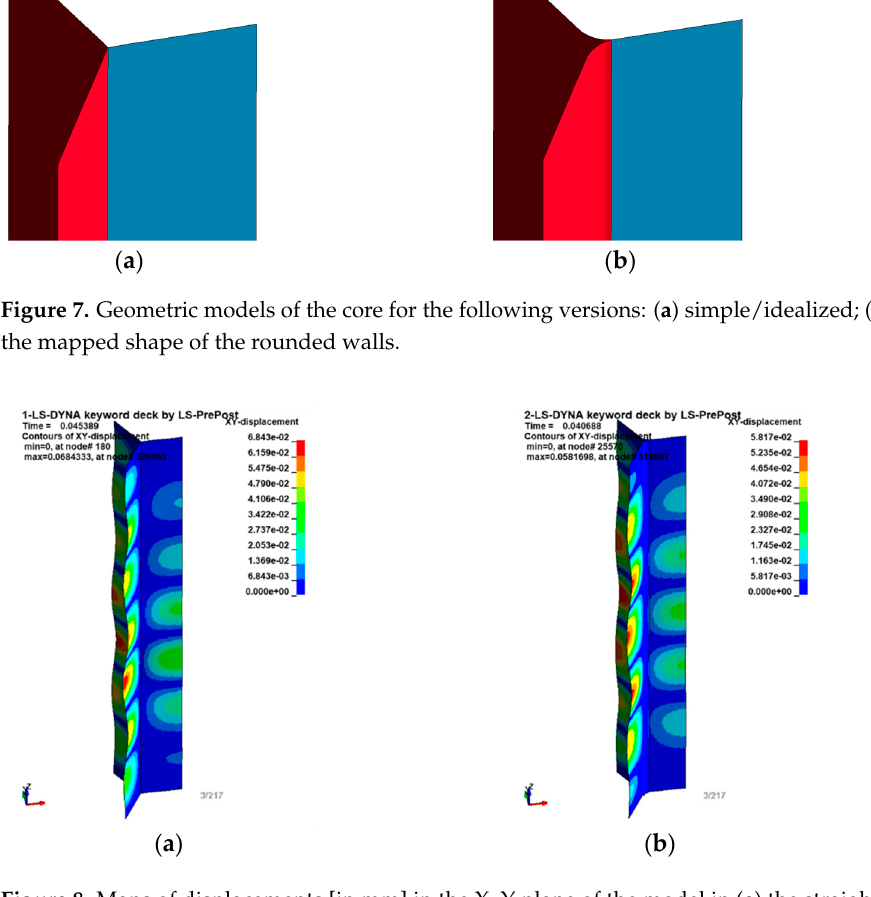
Figure 8. Maps of displacements [in mm] in the X–Y plane of the model in ( a ) the straight/idealized version; and ( b ) with the mapped shape of the rounded walls.